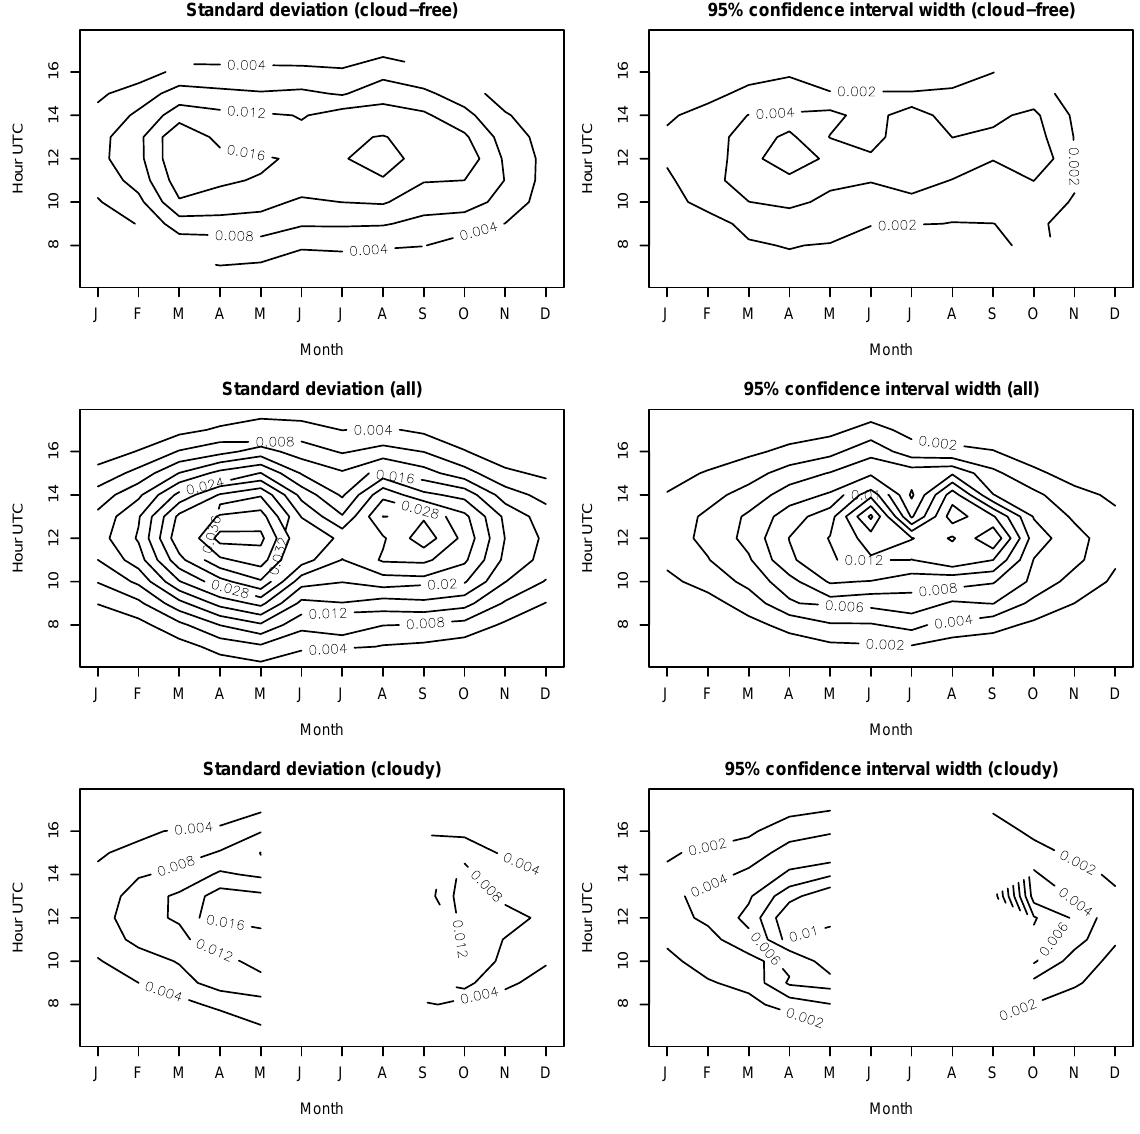
Fig. 12. Isolines of the standard deviation of hourly ultraviolet erythemal irradiance (in Wm − 2 ).